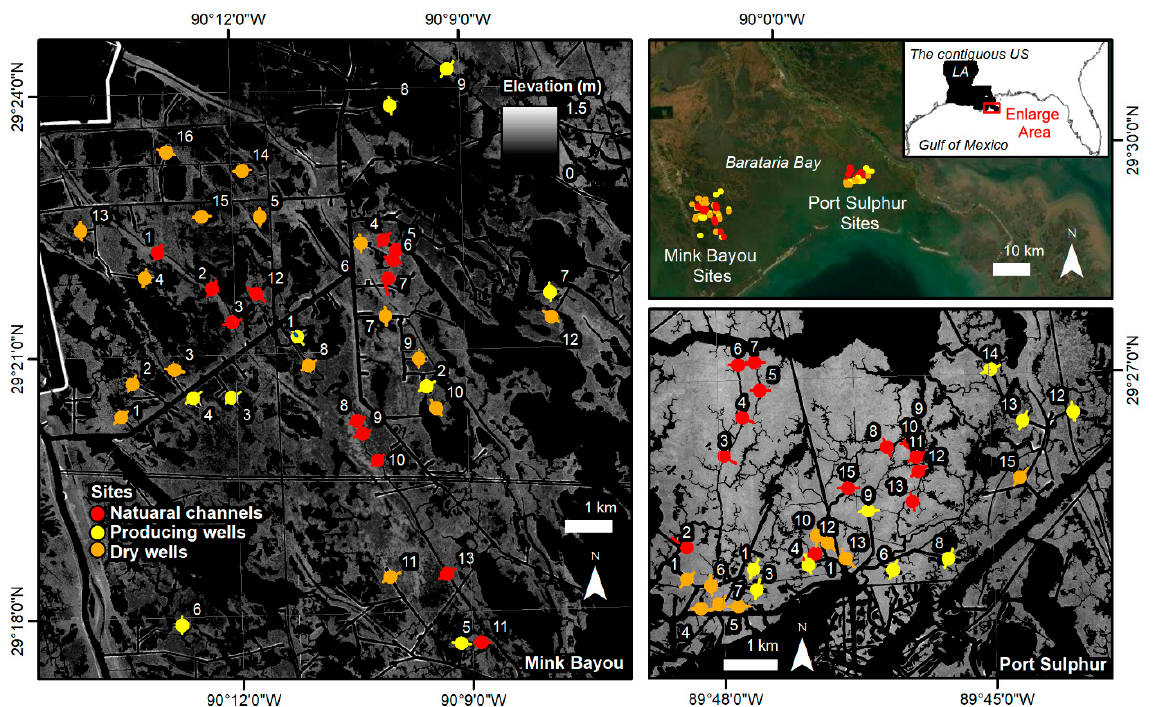
Figure 1. Locations of the three waterway categories near Port Sulphur, LA and in the Mink Bayou area to the west. Both areas are within the Barataria Bay estuary. The line through dots marking the site locations are the 150-m transects on each side of the natural channel or dredged canal.